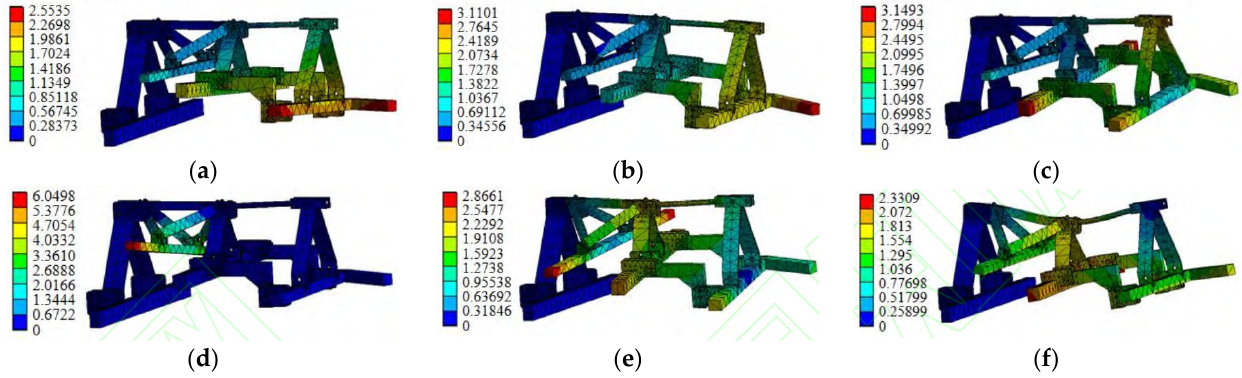
Figure 3. The model of FEA [54]. ( a ) The chopping device; ( b ) simplified structure of the model.